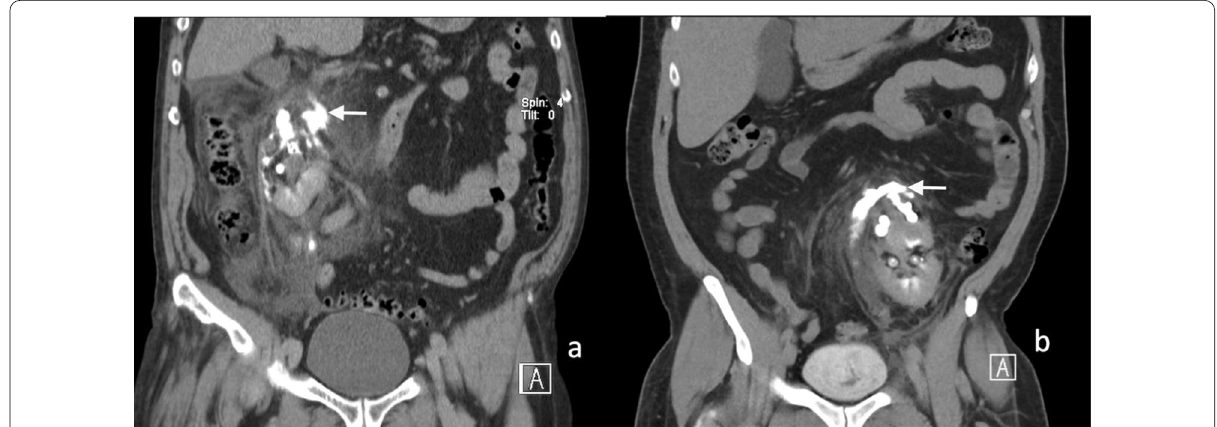
Fig. 5 Coronal delayed excretory phase CT images of calyceal rupture and urinoma formation (white arrows) with perinephric extravasation of contrast in two patients. a Post-ESWL and ( b ) post-pyeloplasty